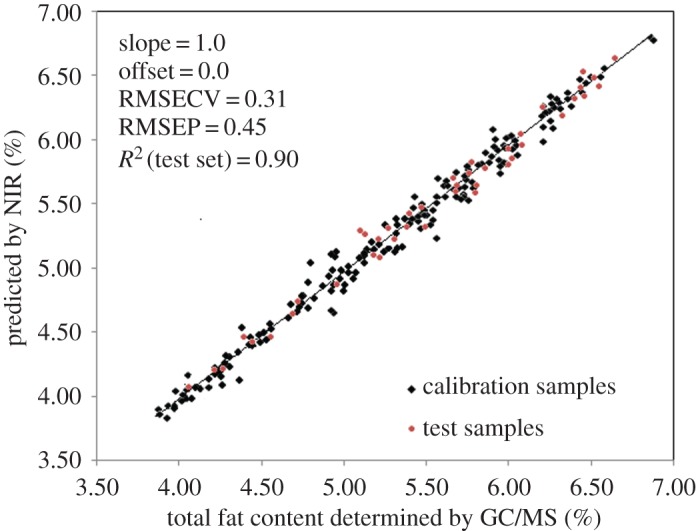
Correlation between the NIRS predicted values and the reference values of total fat in A. japonicus samples by PLS in Step I quantitative model (148 samples in calibration set, in black; 41 samples in test set, in red).